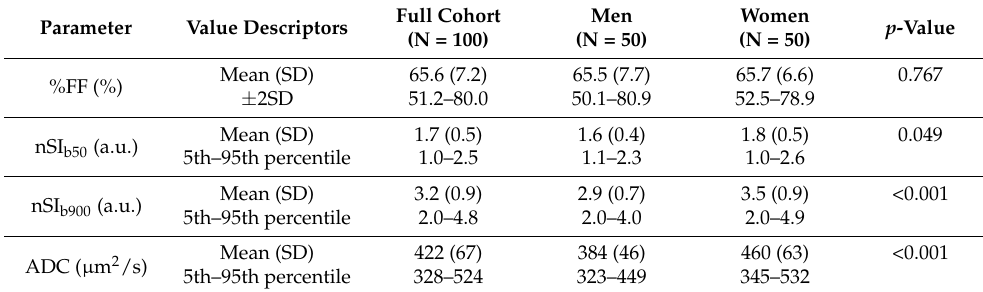
Table 3. Comparisons of imaging-derived apparent diffusion coefficient, normalized diffusion weighted signal intensity and relative fat fraction values for bone marrow.